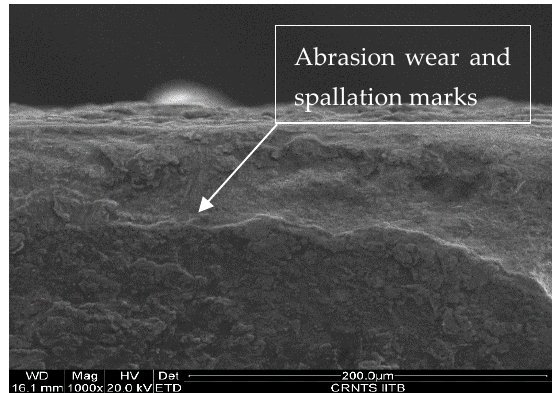
Figure 4. Flank wear of tool with traditional/initial parameters.